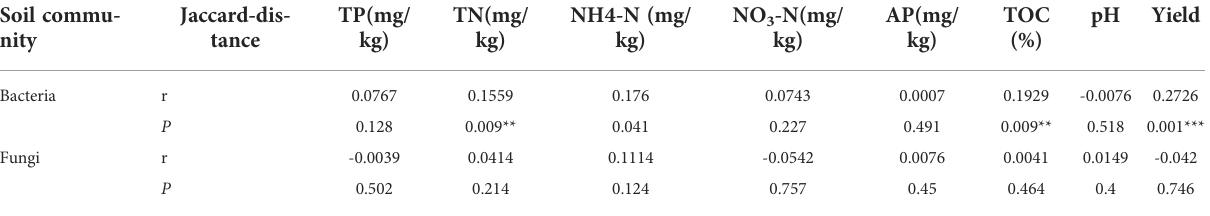
TABLE 2 Mantel test based on Jaccard distance between bacterial and fungal communities with soil properties and potato yield. Soil commu- nity